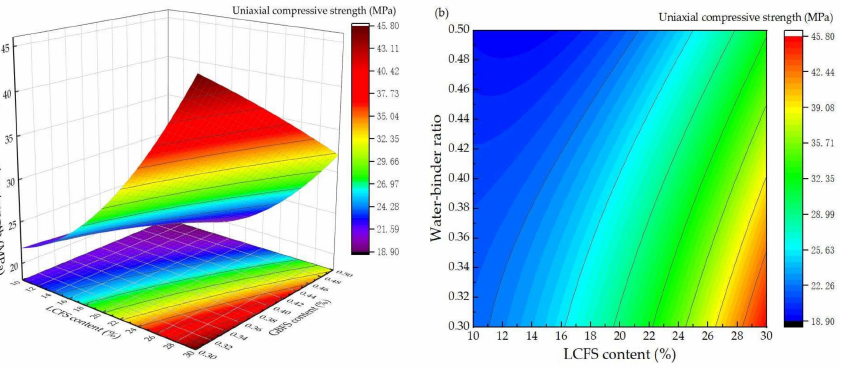
Figure 7. Effect of interaction between LCFS content and water-binder ratio on compressive strength: ( a ) response surface diagram; ( b ) contour